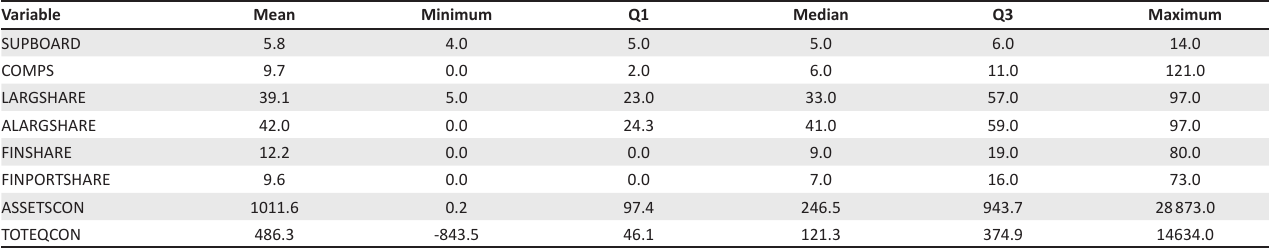
TABLE 3: Values of measuring positions of variables on the continuous scale.